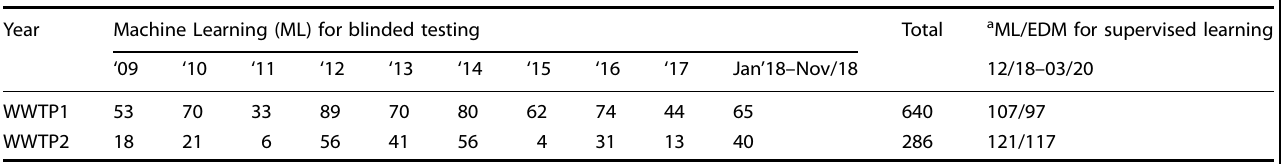
Table 3. Number of potential ‘ spill ’ days detected by machine